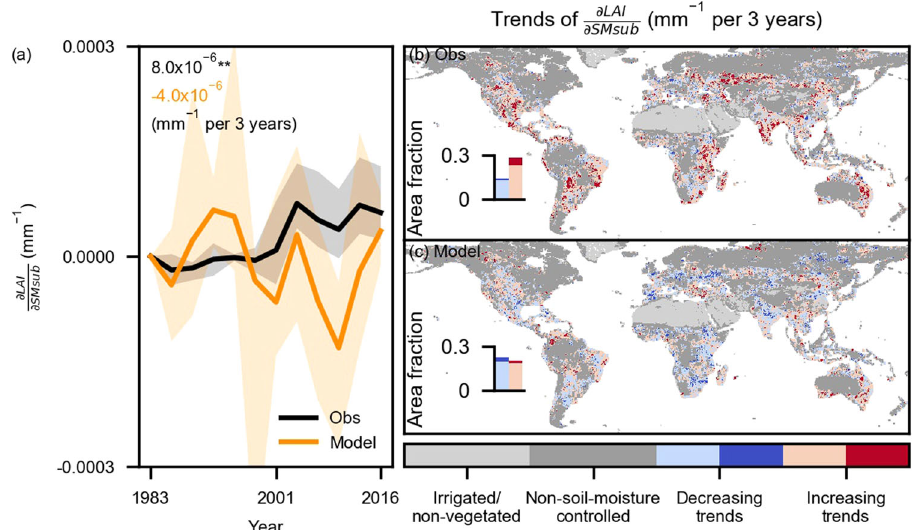
Fig. 3 Trends of LAI sensitivity to sub-surface soil moisture. a Temporal variations of global mean LAI sensitivity to sub-surface soil moisture ( ∂ LAI ∂ SMsub ) computed by 3-year blocks between 1982 and 2017. The y-axis denotes the change since 1982 in respective products or models. Solid lines denote the median results from ensemble observations (Obs) and land surface models (Model); Shaded areas denote interquartile ranges of LAI sensitivity from multiple LAI products and models; Text denotes slopes of trends; ** denotes passing the two-sided signi fi cance test as assessed with Mann-Kendall at p < 0.01 (Methods: Sensitivity trends). b Trends of LAI sensitivity to sub-surface soil moisture in observations and models using ensemble means. c Similar to b but for land surface models. Insets indicate the area fraction of decreasing and increasing trends within the global land area, excluding irrigated and non-vegetated regions. Light blue and red colors denote insigni fi cant changes ( p > = 0.1); dark blue and red colors denote signi fi cant changes ( p < 0.1). In b , c , two-sided signi fi cance tests are done for each grid cell at the p < 0.1 level as assessed with Mann-Kendall ’ s test. See Methods: Auxiliary data about the determination of irrigated/non-vegetated and non-soil-moisture controlled